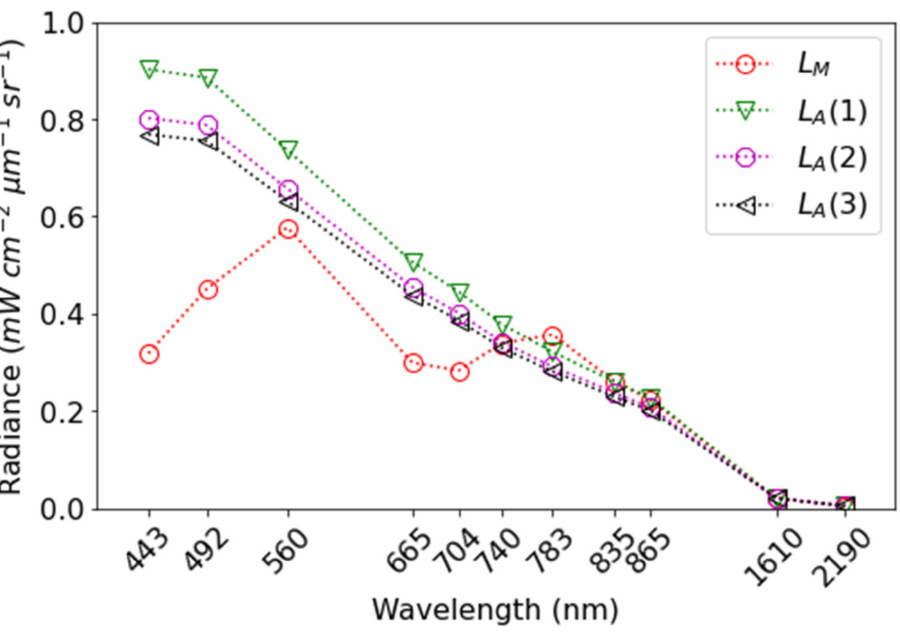
Figure 18. STANDARD-derived radiance of aerosol L A for the first (green), second (purple), and third iteration (black) in the iterative scheme for the sampling station of 11-631. The TOA radiance after correction of Rayleigh scattering, and gas absorption (L M ) is also shown